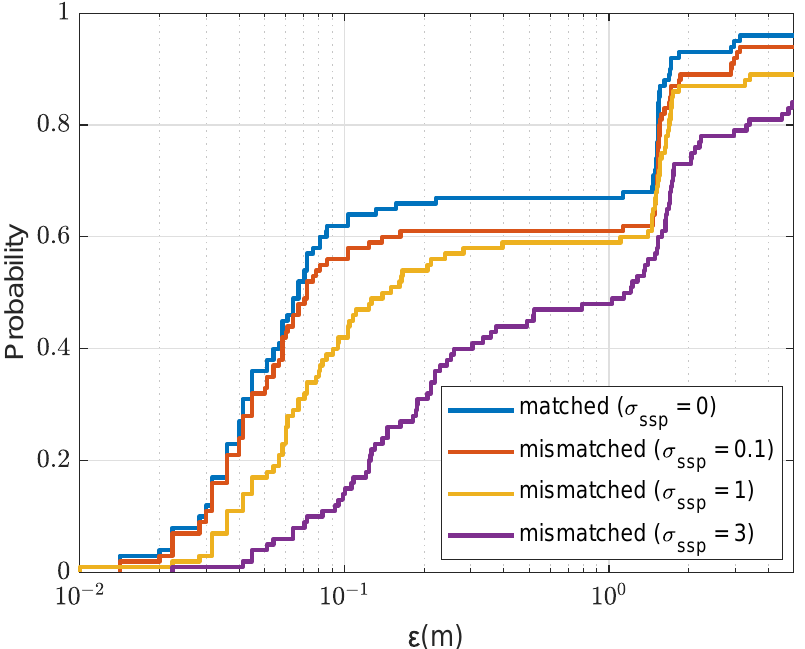
Figure 17. CDF for the localization error ε in mismatched acoustic environments against the variance sound speed σ 2 ssp ; N T = 1; N max = 4, nine points are removed after finding the next coarse AF maximum; the refinement steps, F r = F d = 0.1 m; the size of a refinement area is 2 m × 2 m (as shown in Figure 5a).